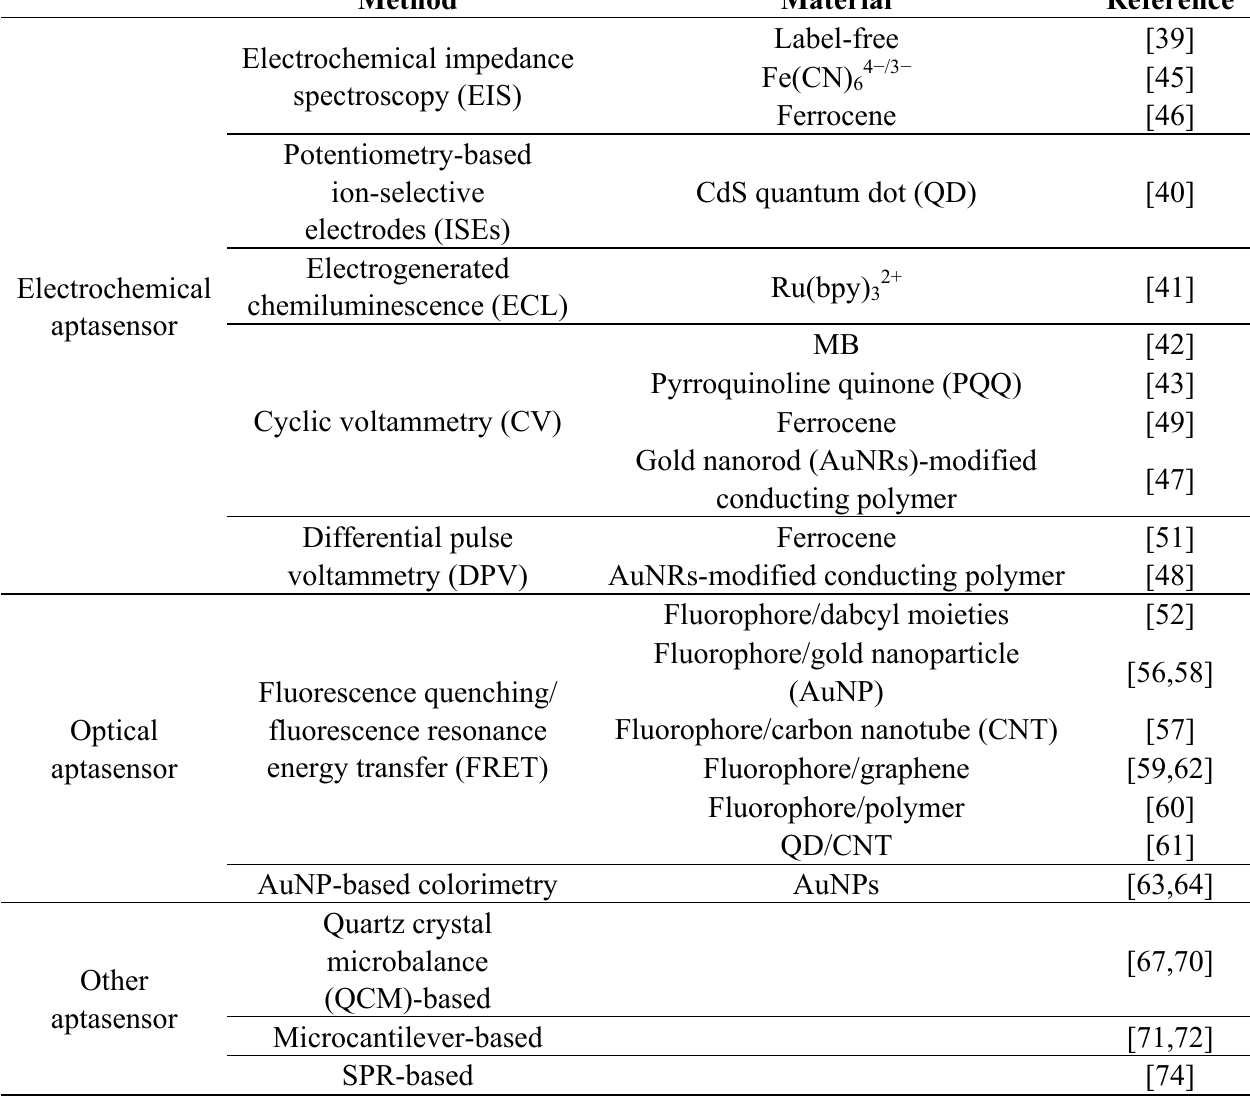
Table A1. Aptamer-based sensor.